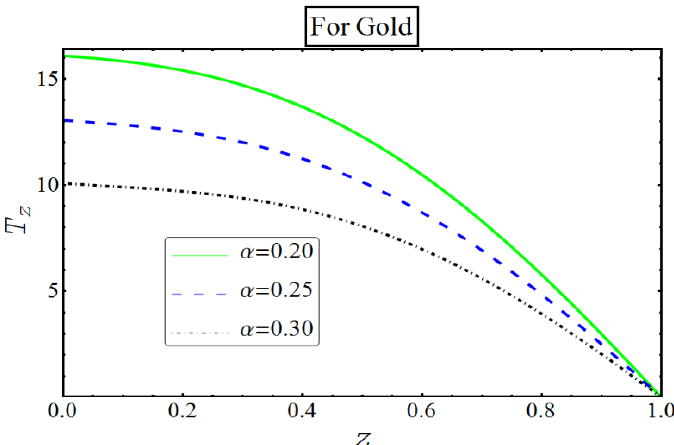
Figure 24. Variation of T z for the thermocapillary parameter.